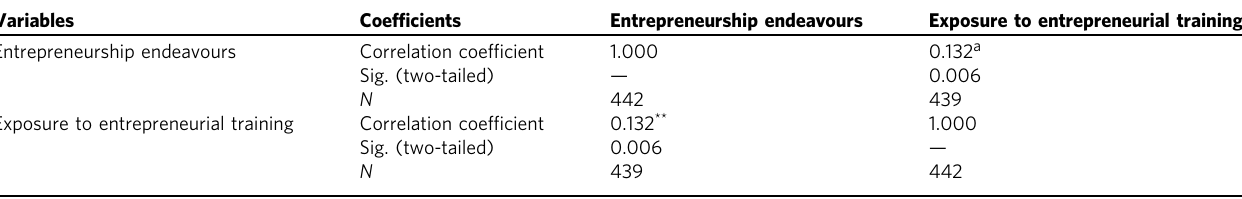
Table 5 Showing relationship between student interest in pursuing entrepreneurship and exposure to business training. Variables